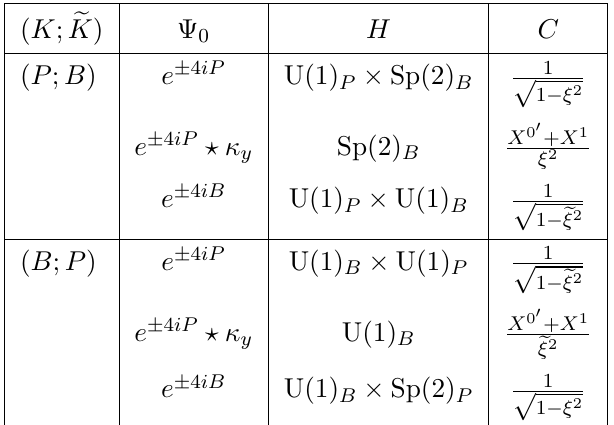
Table 1 . Ground states for (cid:13)uctuations spaces on spinless BGM black holes. denote the identi(cid:12)cation Killing vector and its dual of a BGM black hole with mass M = 1 and spin J = 0, i.e. AdS 3 (cid:2) (cid:24) (cid:2) S 1 . The black hole symmetry group is given by Stab so (2 ; 3) ( K ), i.e. Stab so (2 ; 3) ( P ) = U(1) P (cid:2) Sp(2) B and Stab so (2 ; 3) ( B ) = U(1) B (cid:2) Sp(2) P , which is also the stabilizer p (cid:0)! of the warp factor (cid:24) := K 2 . H and C , respectively, denote the symmetry group and scalar (cid:12)eld of the ground state (cid:9) 0 of a sector of (cid:13)uctuations. There are four distinct moduli spaces, depending on whether C blows up at 1) (cid:24) = 0, i.e. at the BGM singularity; 2) (cid:24) = (cid:6) 1, i.e. at the BGM horizons; q 3) e (cid:24) :=